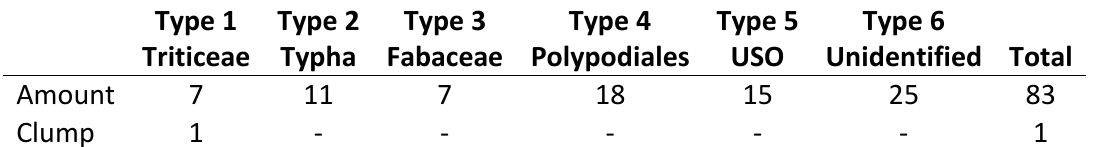
Table 1. Distribution of starch by type. (Percentages are not provided. The quantitative contribution of each type in this study cannot reflect the significance of any taxon in the life support